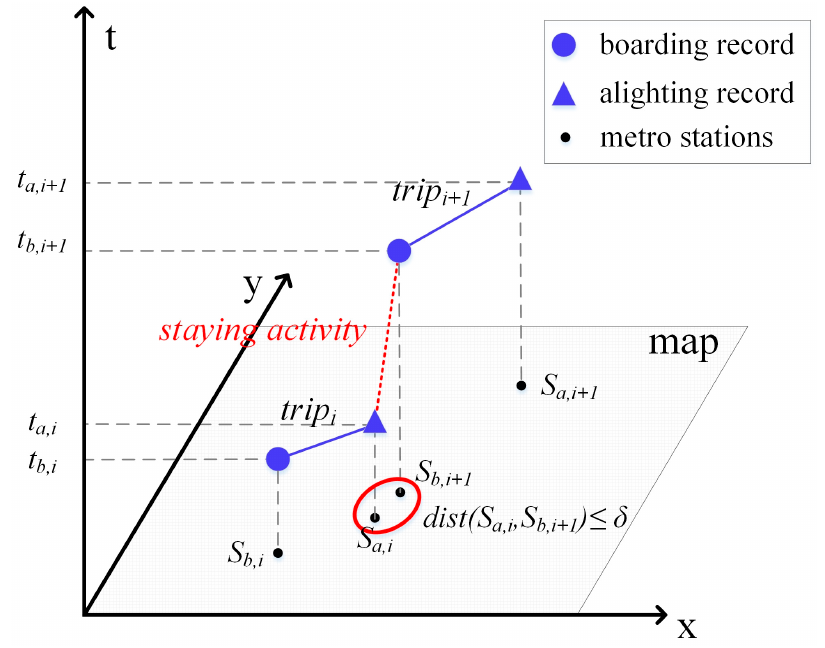
Figure 2. Illustration of staying activity.